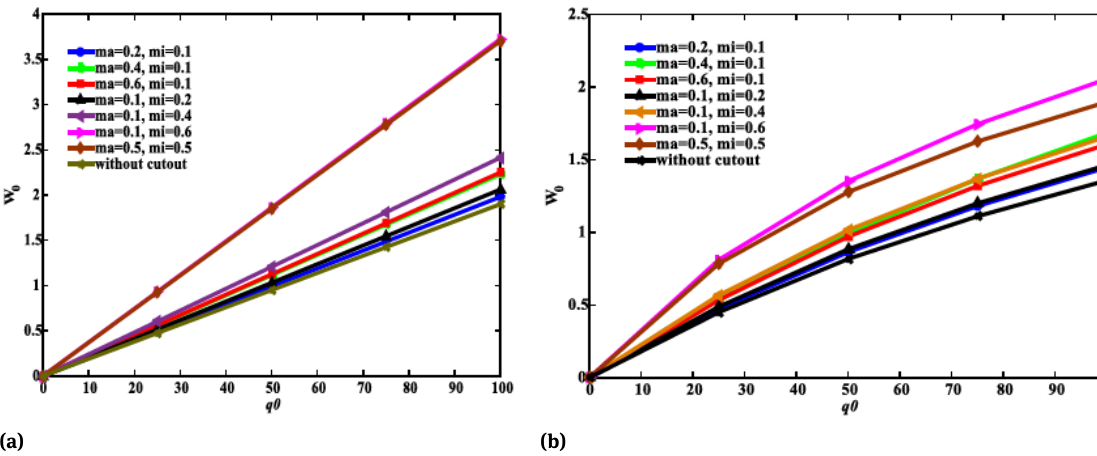
Figure 8: (a) Linear and (b) nonlinear variation of NTMD with loading of LCSP having elliptical cutout